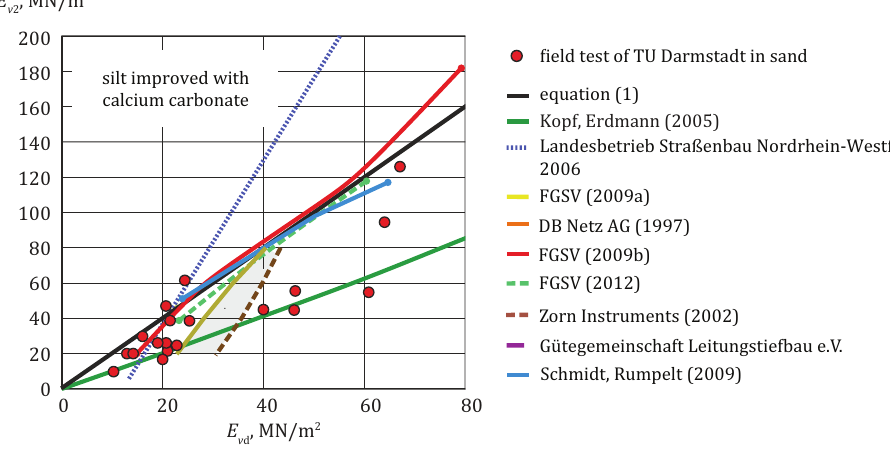
Figure 8. Correlations for cohesive soil improved with fine granular